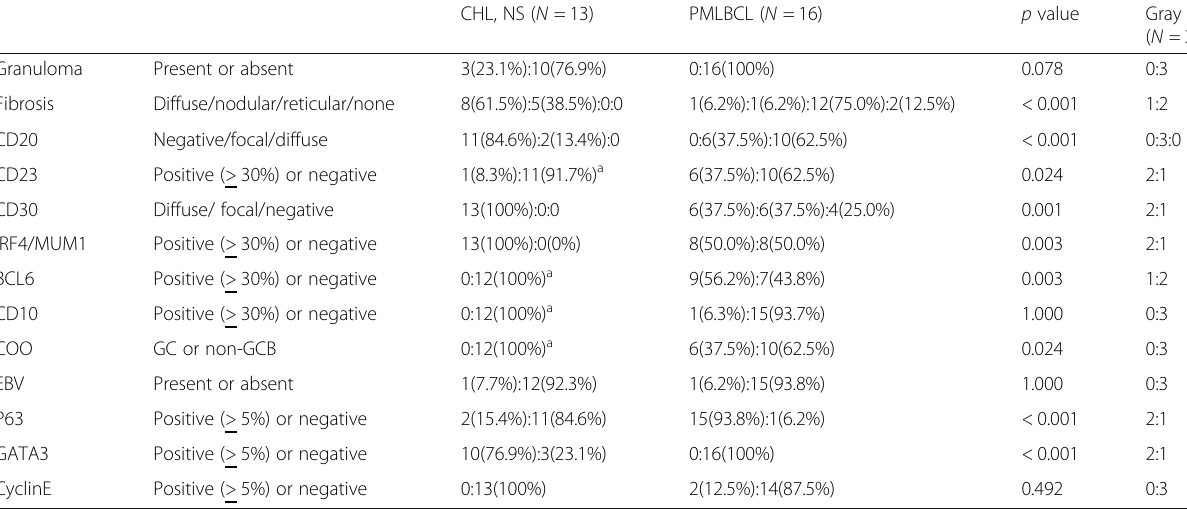
Table 2 Comparison of pathologic